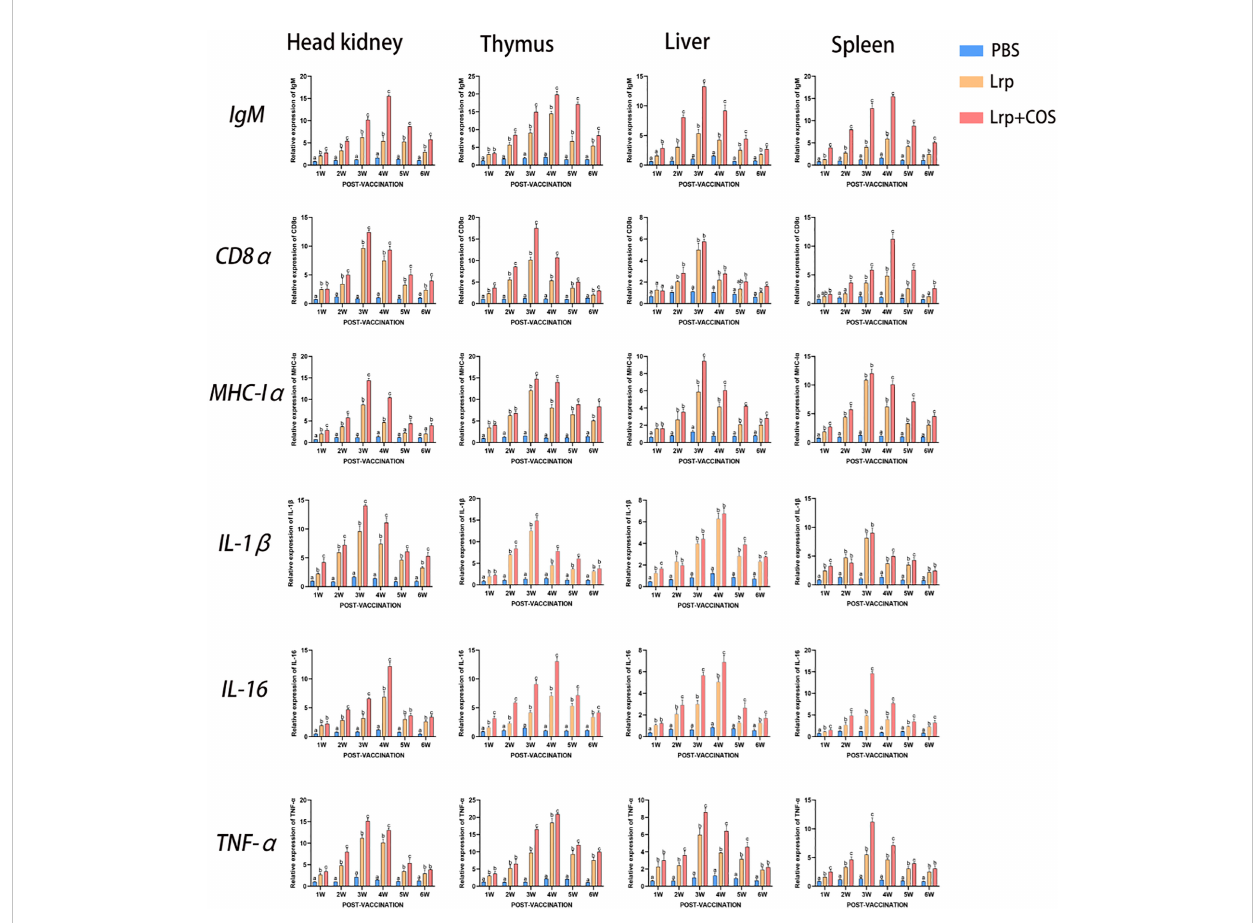
FIGURE 6 qRT-PCR to analyze the transcript levels of IgM , CD8 a , MHC-I a , IL-1 b , IL-16 and TNF- a in the kidney, thymus, liver and spleen of pearl grouper weekly post-vaccination. The mRNA levels of each immune-related gene were normalized to the mRNA levels of b -actin , and the relative expression was calculated. Bars represented the mean relative expression (n=3) and error bars represented standard errors. Signi fi cant differences ( p < 0.05 ) were marked by a,b and